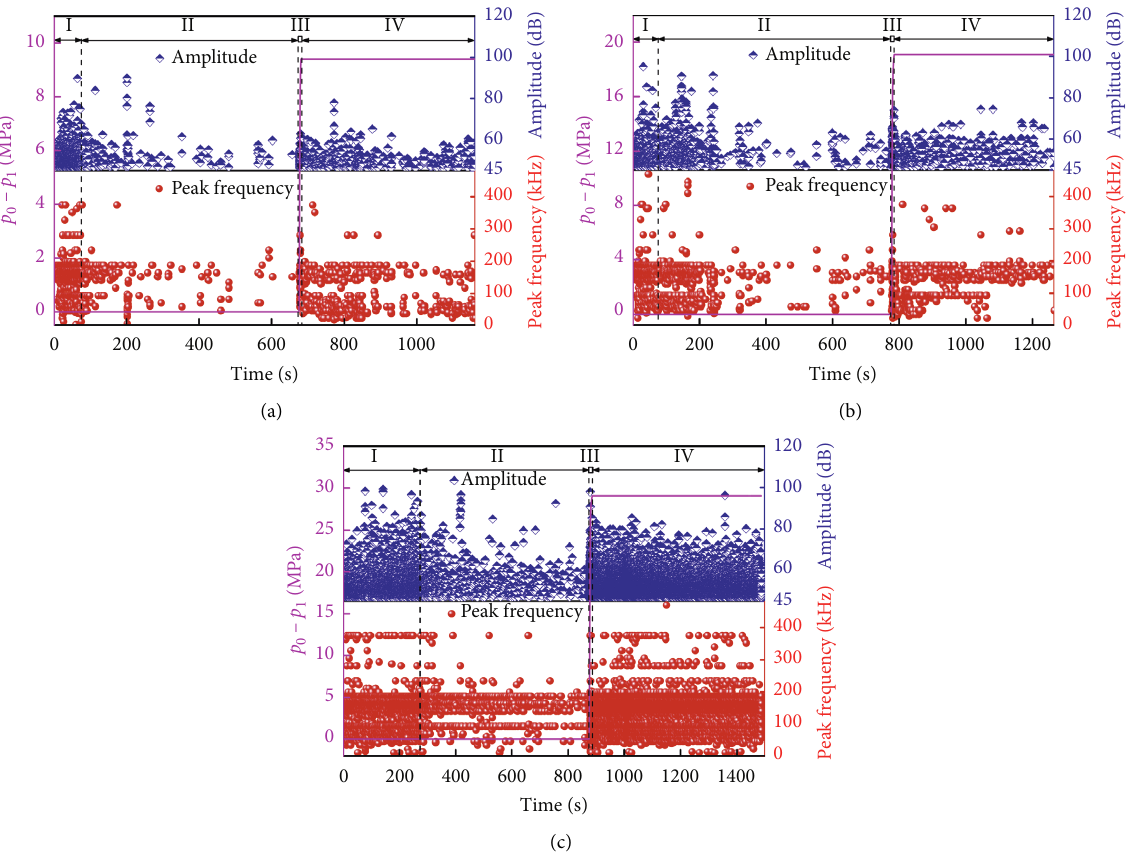
Figure 9: Peak frequency and amplitude of AE signals during the whole test process under different initial confining stress ((a) 10, (b) 20, (c)